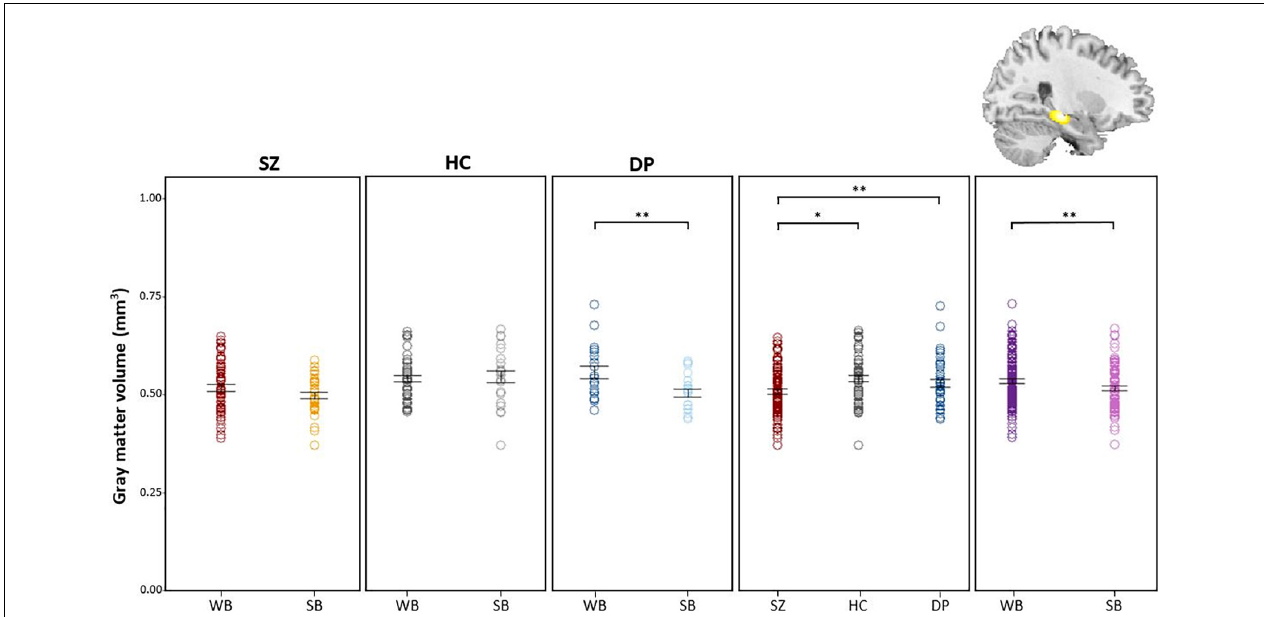
FIGURE 2 | Post hoc comparisons of extracted GM values show decreased volume of the hippocampus in DP SB vs. DP WB patients, in SZ patients vs. HC participants, in SZ patients vs DP patients and in WB vs SB individuals. WB = Winter-born; SB = Summer-born; SZ = Schizophrenia; DP = Depression; HC = Healthy Control; ∗∗ p < 0.01, ∗ p <